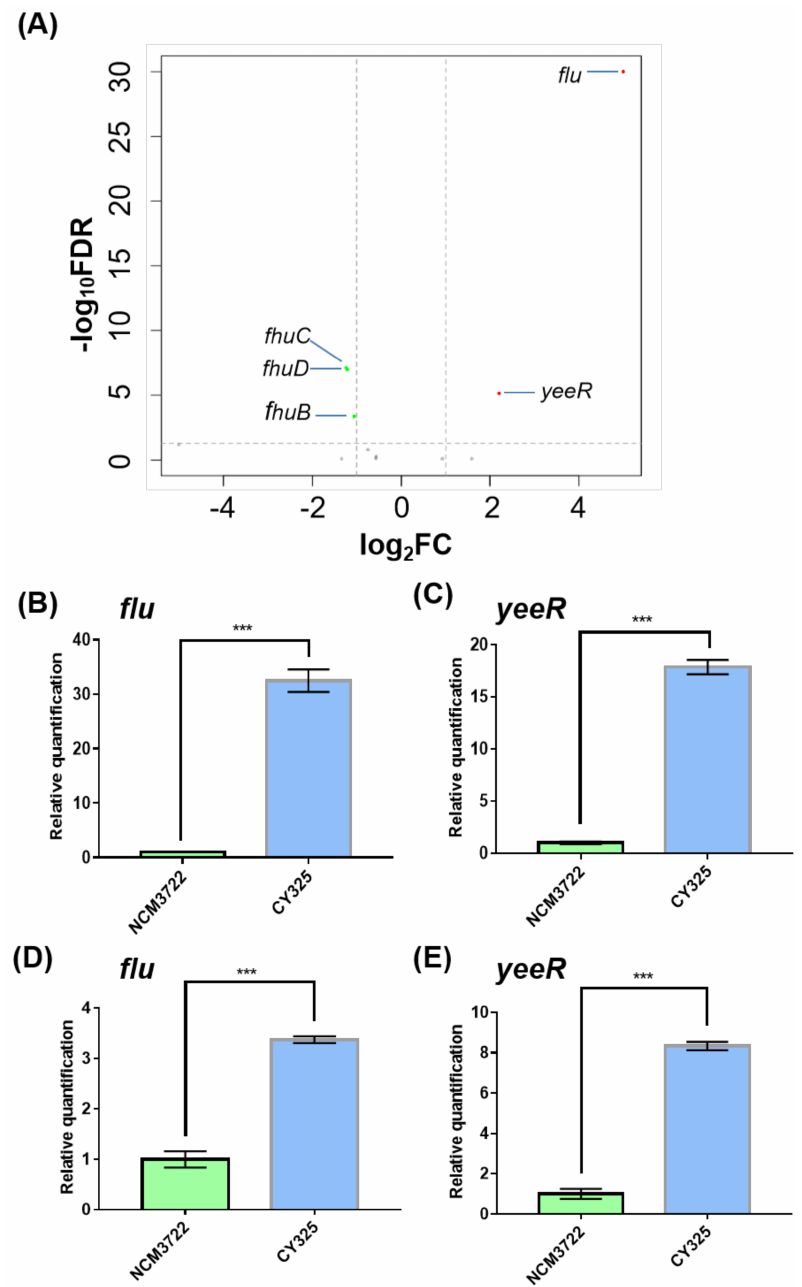
Figure 1. Genes responding to GcvB. ( A ) Volcano map comparing the expression of genes in the gcvB knockout strain CY325 versus that in the wild-type strain NCM3722. The horizontal dashed line points to q -value (FDR) = 0.01 on y -axis and the vertical dashed lines point to 2-fold cutoff of the expression on x -axis. Red dots indicate up-expressed genes; green dots indicate down-expressed genes; grey dots indicate genes showed no significant changes. Note that the data points of the remaining genomic genes carrying a q -value (FDR) = 1 with a corresponding − log 10 FDR = 0 were not shown. ( B , E ) Gene expression of flu and yeeR detected using RT-qPCR in the gcvB knockout strain CY325 and in the wild-type strain NCM3722 grown in glucose minimal medium ( B , C ) or in LB rich medium ( D , E ). The mRNA level of each gene in NCM3722 was normalized to 1 and that in CY325 was determined relative to this value. The relative expression was shown as the average ± S.D. of three independent experiments. *** p < 0.001 using Student’s t